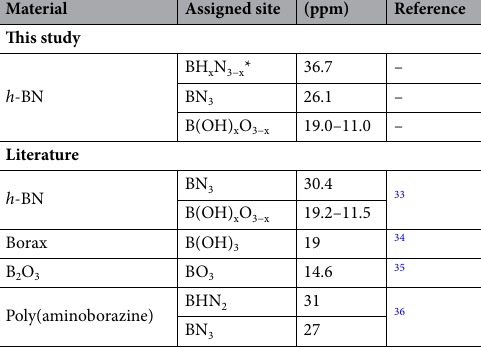
Table 3. Summary of experimentally measured and literature 11 B SS-NMR parameters. *The assigned state was determined by closest literature reported value for BN